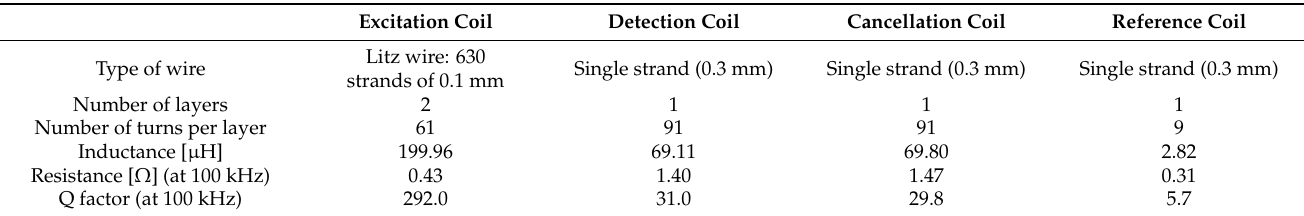
Table 1. Properties of the coils used in the system.